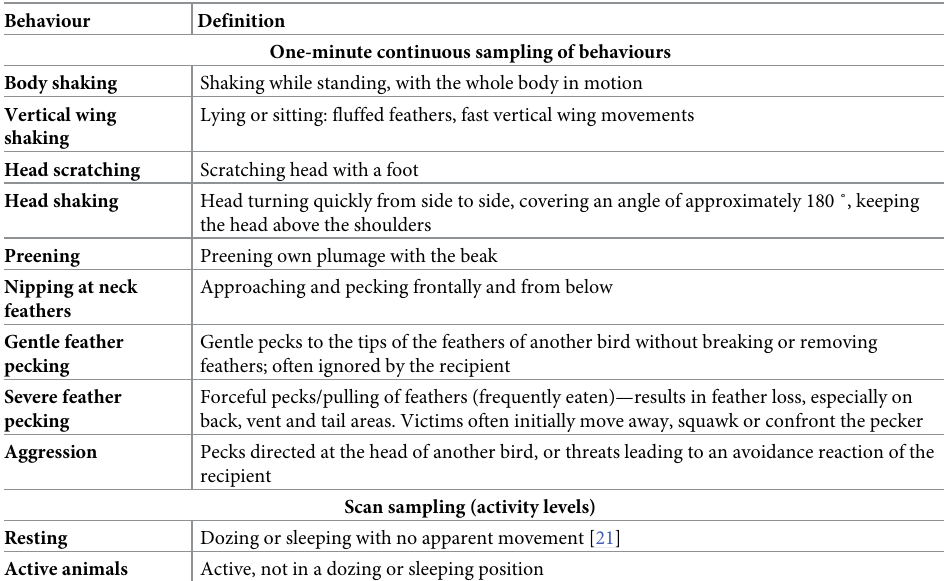
Table 2. Behavioural activity assessment